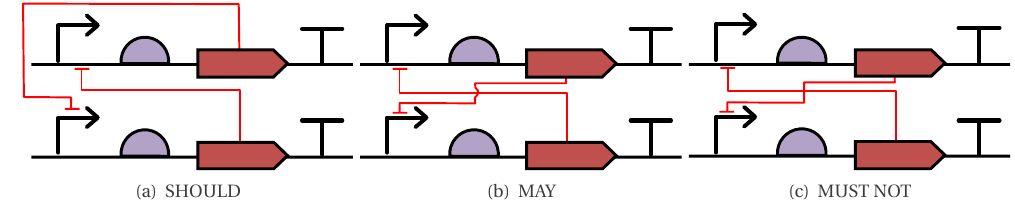
Figure 18: Examples of recommended, allowed, and forbidden relationships between two interactions in a mutual repression system: (a) non-crossing is recommended, (b) using a crossover pattern is allowed, but (c) crossing without a crossover pattern is forbidden, since the relationship between the two edges is ambiguous.